Question: State the chart type depicted above.
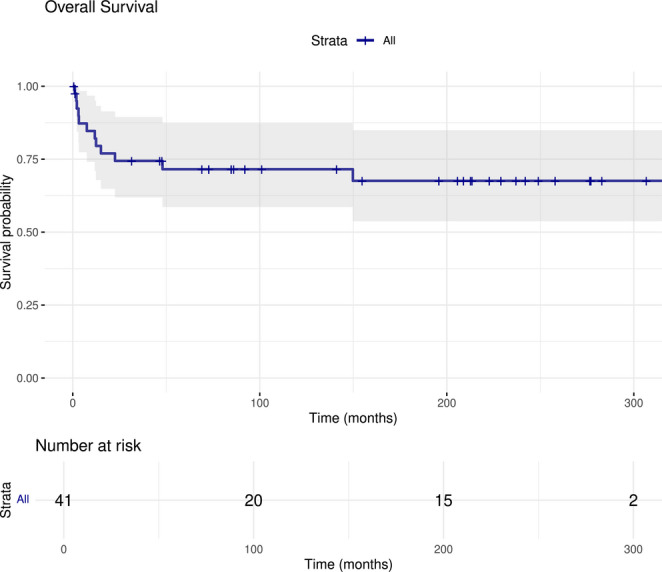
Answer: survival